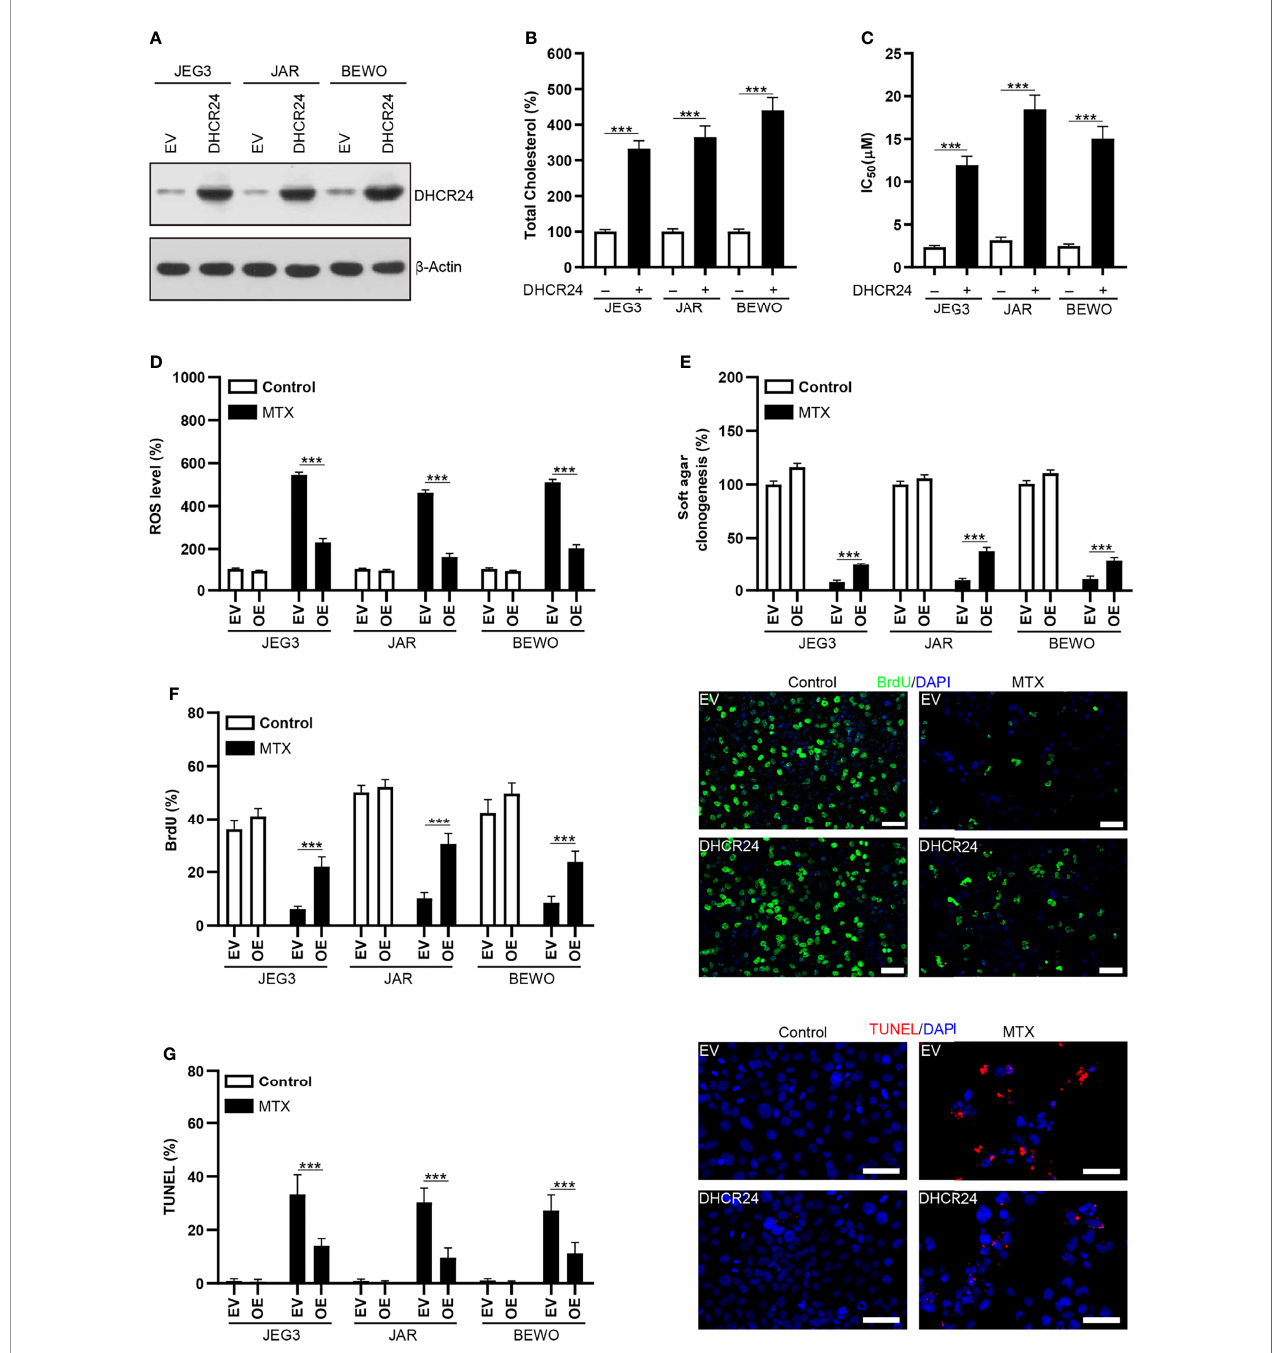
FIGURE 4 | Over-expression of DHCR24 expression in fl uences cellular cholesterol level, ROS accumulation and chemosensitivity to MTX in GTN cells. (A) Overexpression of DHCR24 in GTN cell lines. (B) Overexpression of DHCR24 increased cellular cholesterol level in GTN cells. n=4, ***P<0.001. (C) Over-expression of DHCR24 increased the chemoresistance to MTX in GTN cell lines. n=4, ***P<0.001. (D) Over-expression of DHCR24 attenuated ROS accumulation following MTX treatment (3 m M) in GTN cells. The ROS level or caspase-3 activity in EV of each cell line without MTX treatment was regarded as 100%, respectively. n=4, ***P<0.001. (E) Over-expression of DHCR24 rescued soft agar clonogenesis after MTX treatment (3 m M) in GTN cell lines. The soft agar colony in EV of each cell line without MTX treatment was regarded as 100%, respectively. n=4, ***P<0.001. (F) Over-expression of DHCR24 increased BrdU incorporation after MTX treatment (3 m M) for 96 hours in JEG3, JAR, and BEWO cells. n=4, ***P<0.001. Micrographs showed the result of JAR cells. Bars: 100 m m. (G) Over-expression of DHCR24 reduced TUNEL-labeled cells after MTX treatment (3 m M) for 96 hours in JEG3, JAR, and BEWO cells. n=4, ***P<0.001. Micrographs showed the result of JAR. Bars: 100 m